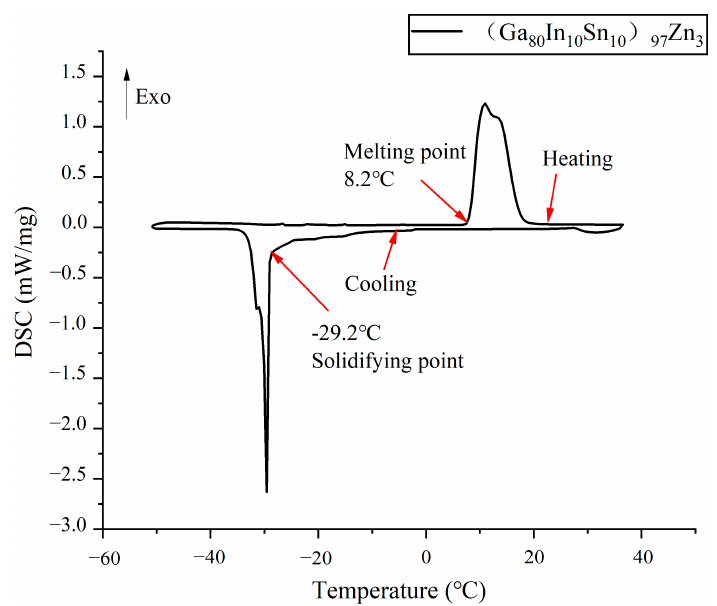
Figure 3. DSC test curve of (Ga 80 In 10 Sn 10 ) 97 Zn 3. .